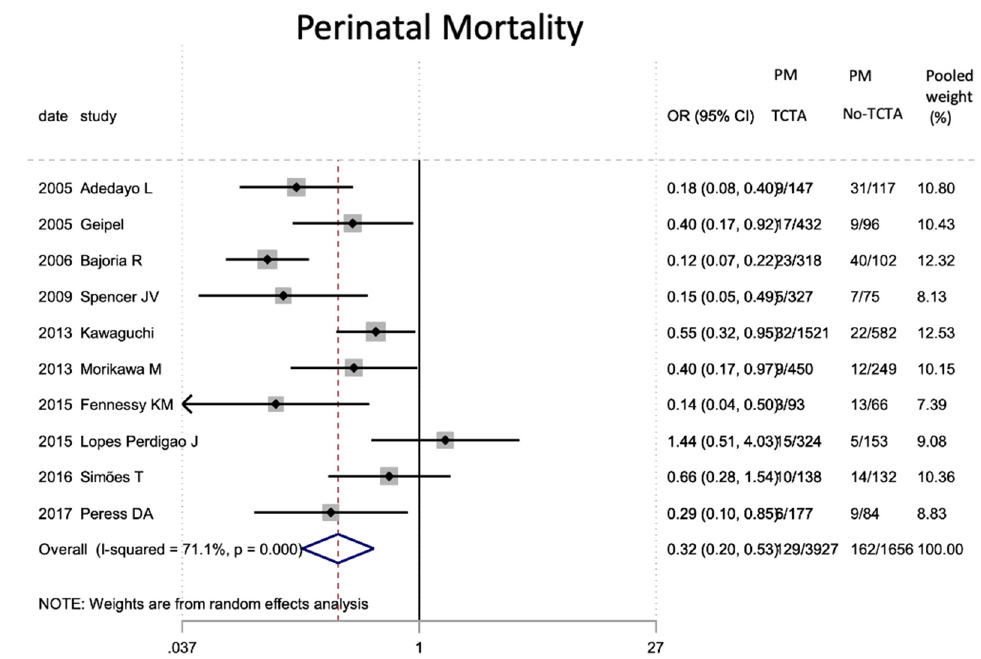
Figure 13. Results of the meta-analysis on the effect of chorionicity (TCTA vs no TCTA) on the development of severe stage III-IV intraventricular hemorrhage. IVH: intraventricular hemorrhage; TCTA: trichorial-triamniotic, non-TCTA: non-trichorial-triamniotic. OR = odds ratio, CI = confidence interval.